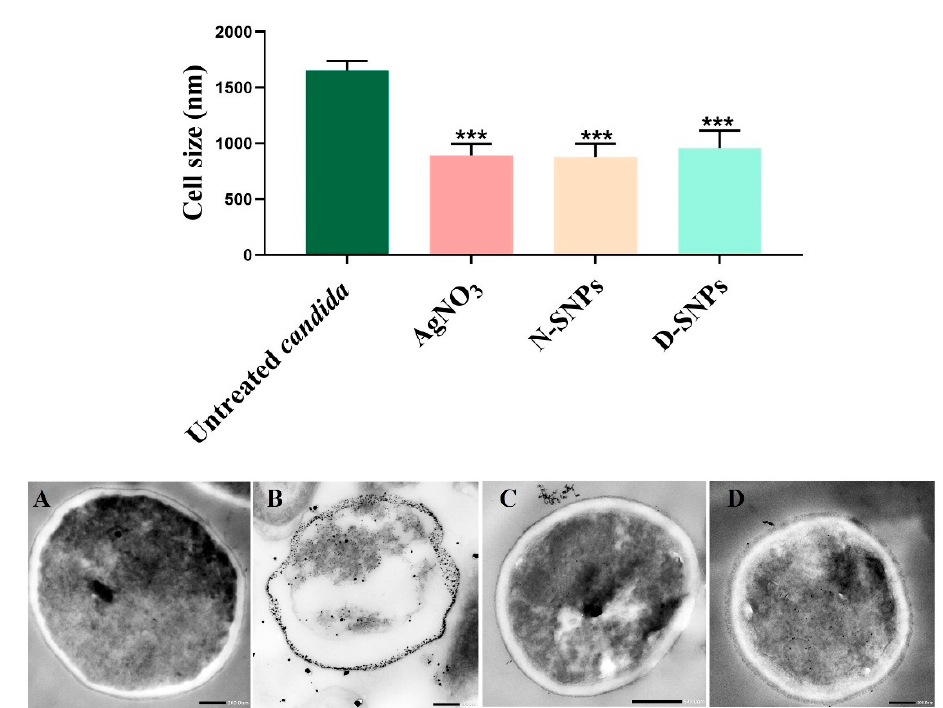
Figure 4. Bar graph and TEM micrographs depicting the diameter of Candida albicans cells (nm) before ( A ) and after AgNO 3 ( B ), N-SNP ( C ), and D-SNP ( D ) treatment. Scale bars: 200 nm in A, B, and D; and 500 nm in C. Data were collected from at least three independent assays and are presented as means ± SEM. *** p < 0.0001 vs. untreated C. albicans .